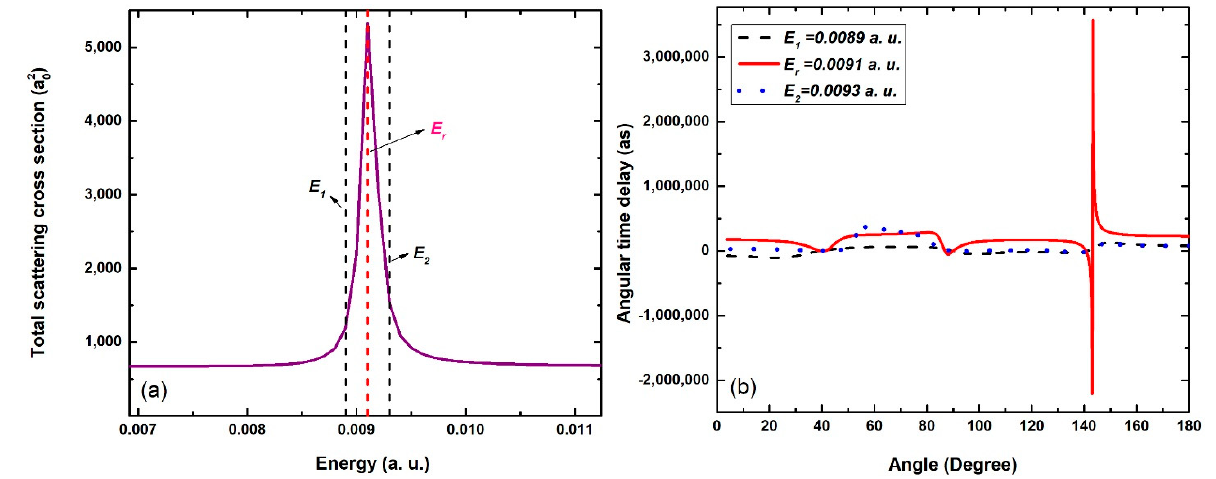
(cid:0) ∆ (cid:1) t 0–9 ( k , θ ) plotted ( ) 0 9 ( , ) t k θ − Δ